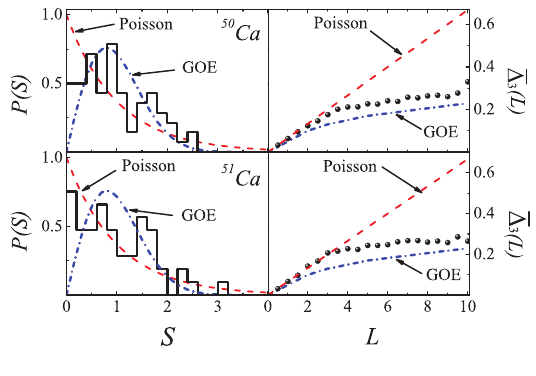
Figure 3. Level spacing distribution P ( S ) (left panel) and spec- tral rigidity ∆ 3 ( L ) (right panel) for the J = 0 levels in 50 Ca with G = 0 . 331 MeV and for the J = 3 / 2 levels in 51 Ca with G = 0 . 291 MeV. P ( S ) and ∆ 3 ( L ) for 50 Ca are of the GOE type, while those for 51 Ca are of the Poisson